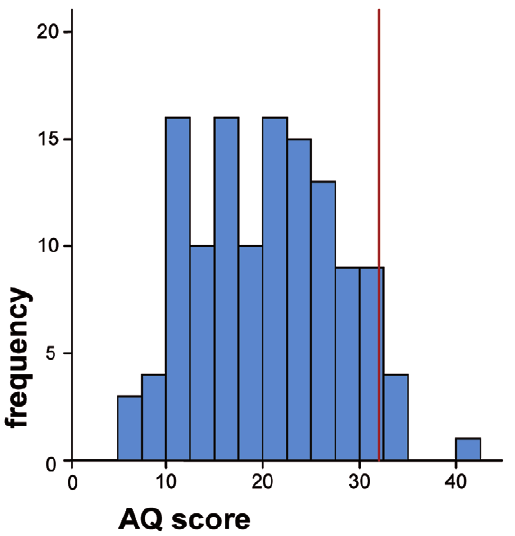
Figure 2. Distribution of AQ scores, showing cut-off of 32.